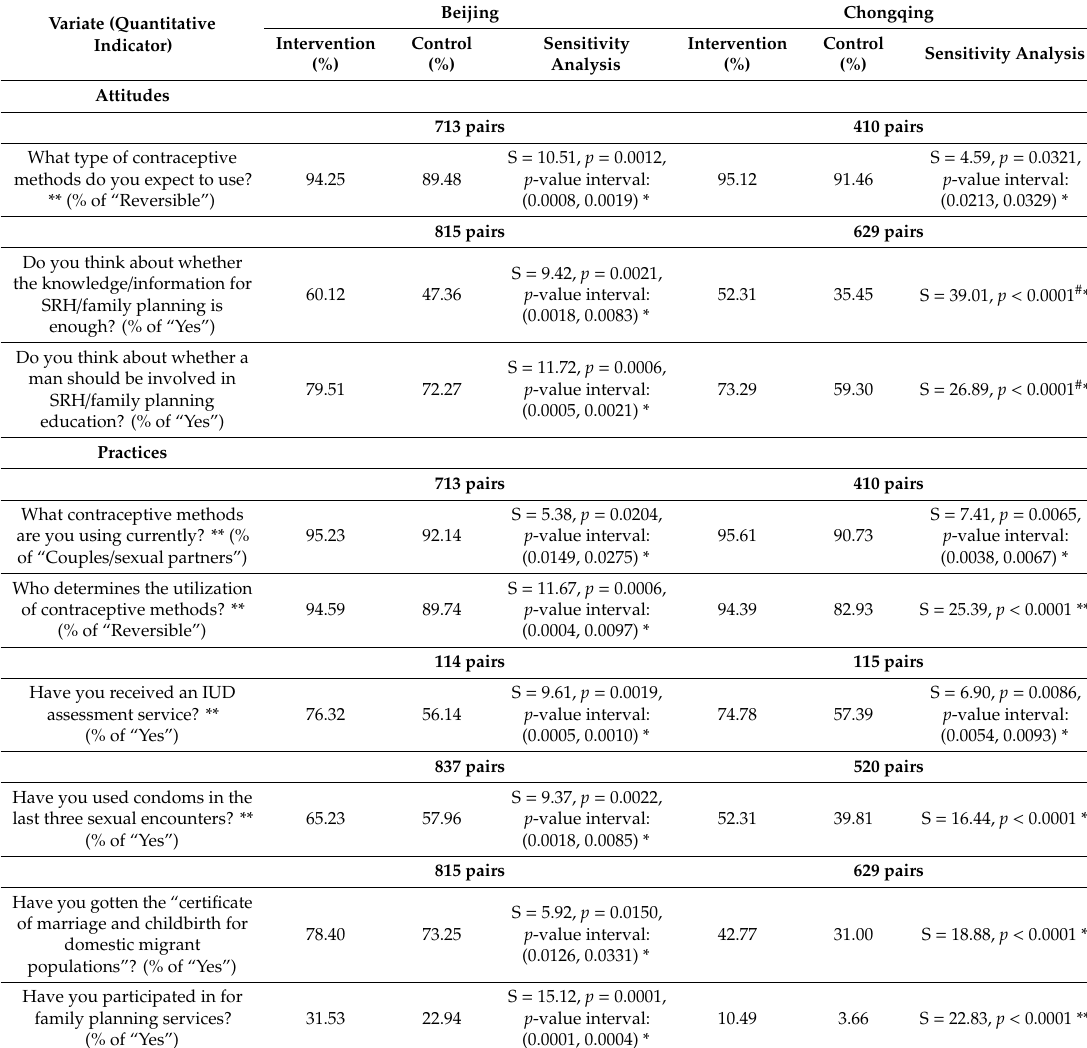
Table 3. Net e ff ects of the intervention on attitudes and practices among the participants by the McNemar